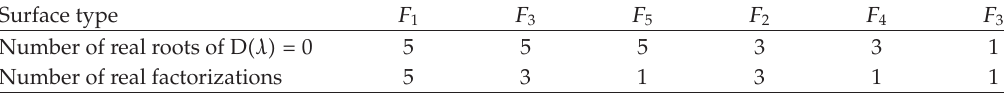
Table 2: A classification of nonsingular cubic surfaces (cid:2) derived from (cid:7) 14 (cid:8)(cid:3) . Surface type F 1 F 3 F 5 F 2 F 4 F 3 Number of real roots of D (cid:2) λ (cid:3) (cid:4) 0 5 5 5 3 3 1 Number of real factorizations 5 3 1 3 1